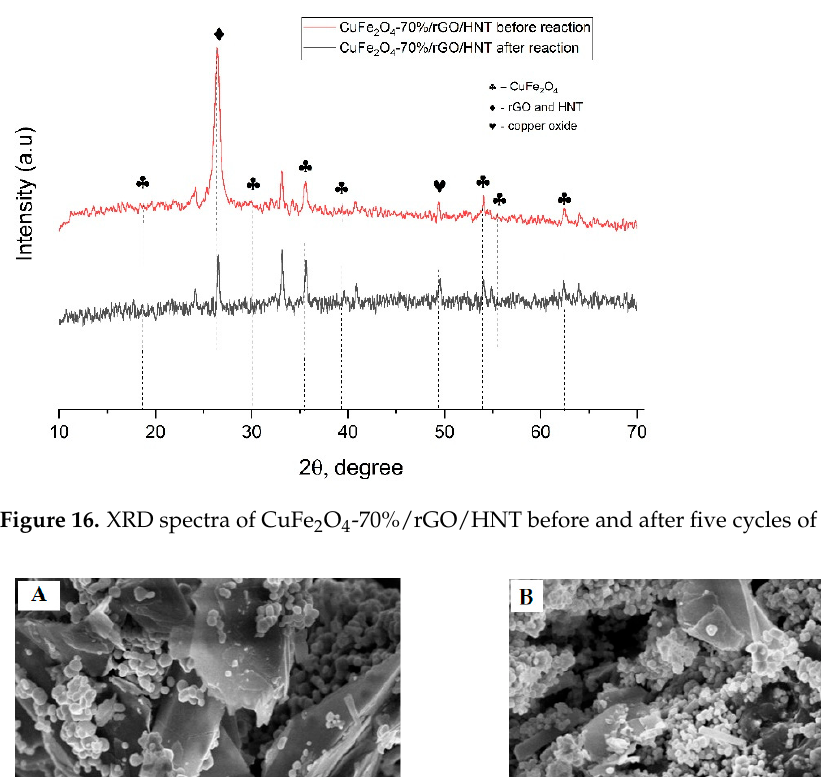
Figure 15. CIP conversion after five cycles of regeneration (catalyst: CuFe 2 O 4 -70%/rGO/HNT; reac- tion time: 5 h).